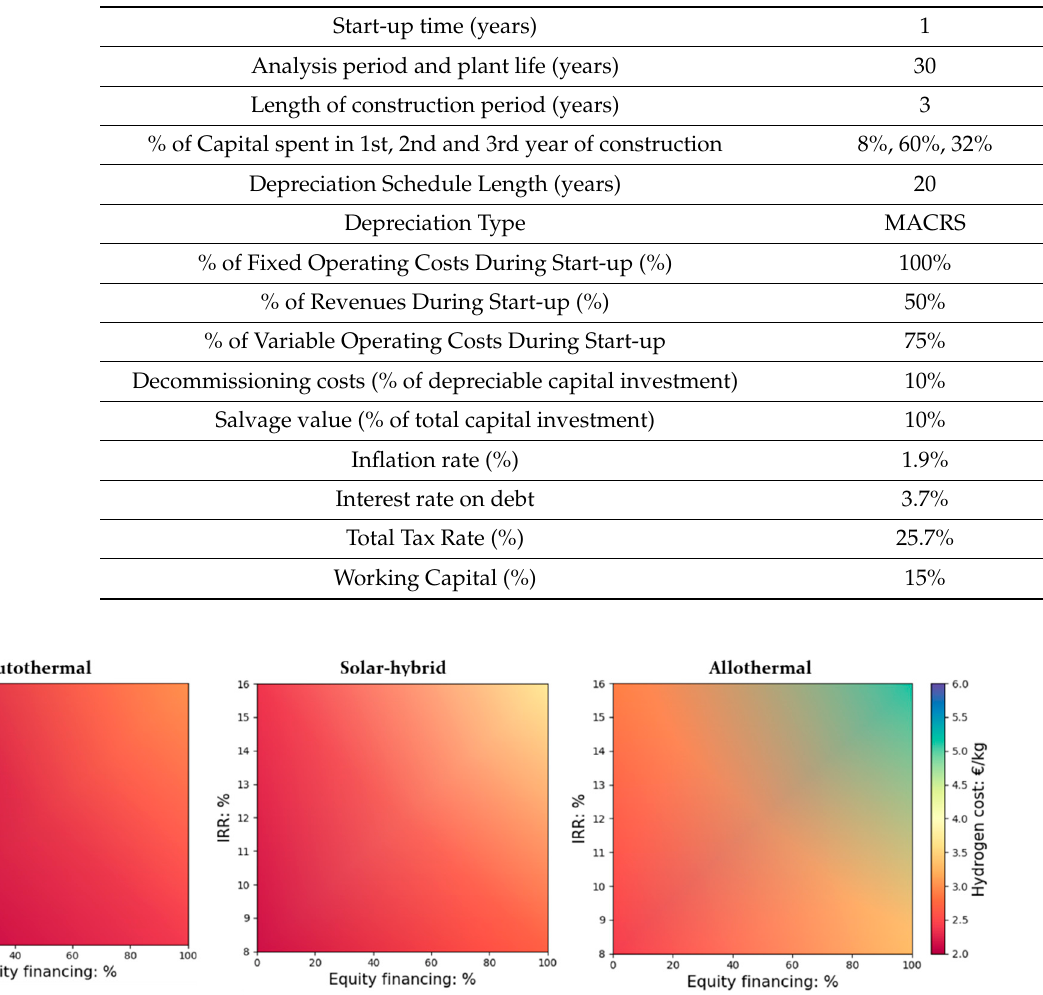
Figure 2. Impact of equity financing (%) and IRR on the cost of H 2 (DC = 150,000 kg H 2 /day and a biomass reference price of 0.1 €/kg and land cost of 12.9 €/m 2 ).